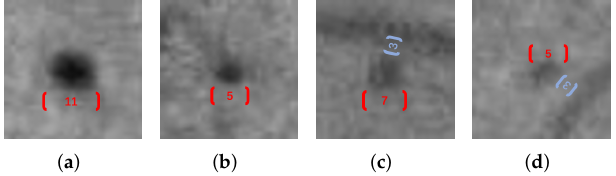
Figure 6. Illustrative example of the optimal parameter settings of different candidates. ( a – d ) are MAs in different environments, with different pixel widths and distances from the adjacent blood vessel. These two values are marked by red and blue markers respectively. Table 3. Local structural